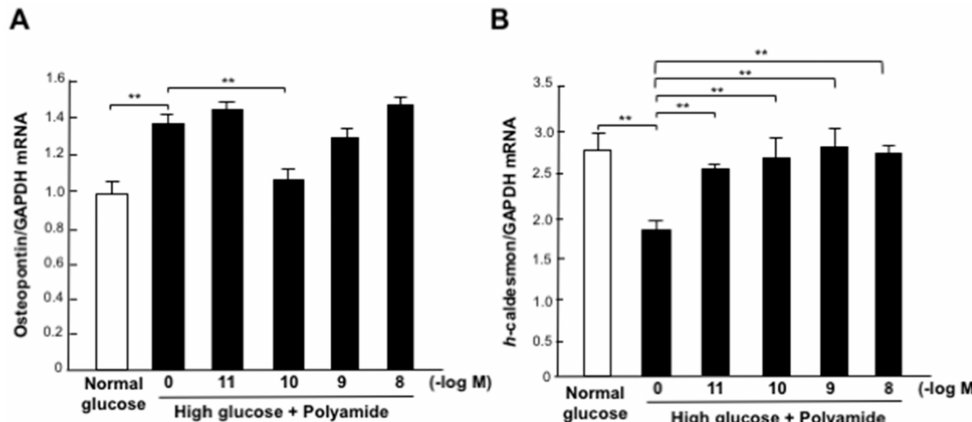
Figure 4. Effects of upstream stimulatory factor 1 (USF1) pyrrole-imidazole (PI) polyamide on the expression of phenotype marker mRNAs in mesangial cells (MCs) with high-glucose stimulation. ( A ) Expression of osteopontin mRNA in MCs treated with high-glucose stimulation and USF1 PI polyamide-3. ( B ) Expression of h -caldesmon mRNA in MCs treated with high-glucose stimulation and USF1 PI polyamide-3. Data are the mean ± SEM ( n = 6). ** p < 0.01 between indicated columns.